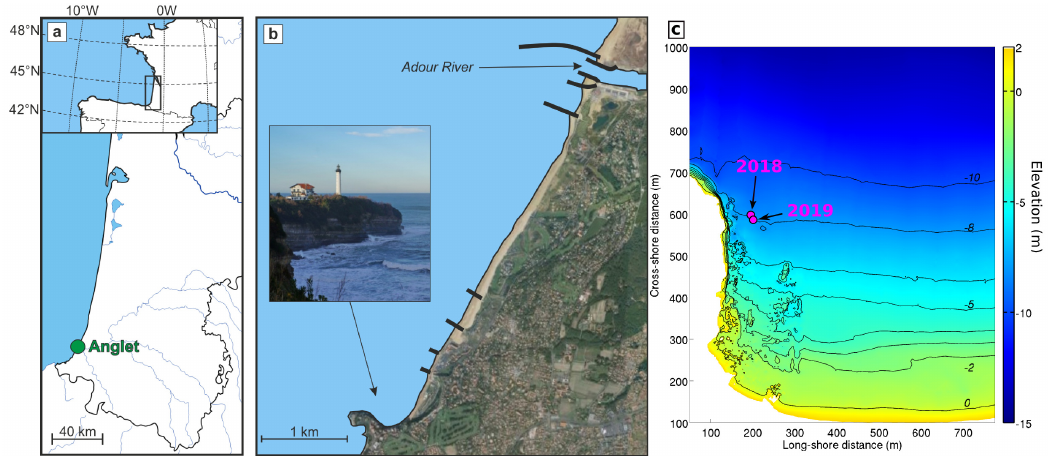
Figure 2. ( a , b ) Location map of Anglet beach and Petite Chambre d’Amour beach (PCA), ( c ) nearshore bathymetry with location of the current meters for both deployments (IGN69